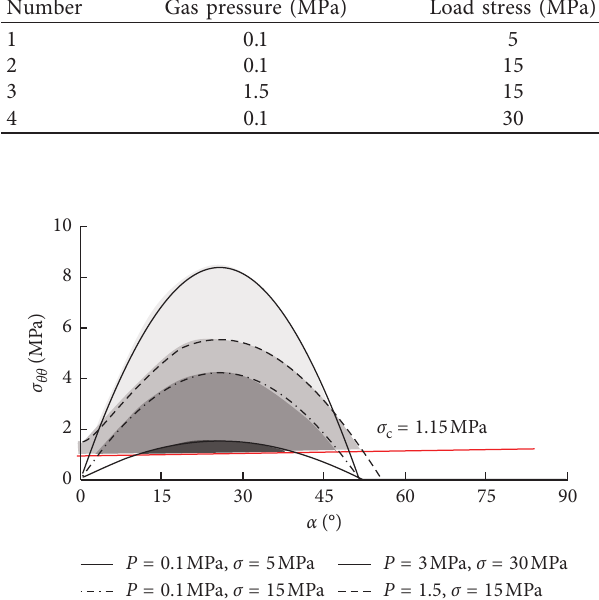
Figure 10: Variation of the maximum circular stress at the crack tip of four coal samples with the crack